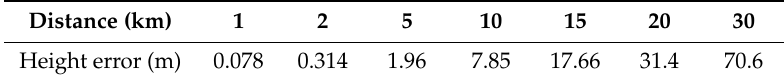
Table 1. The influence of the distance and Earth curvature on height